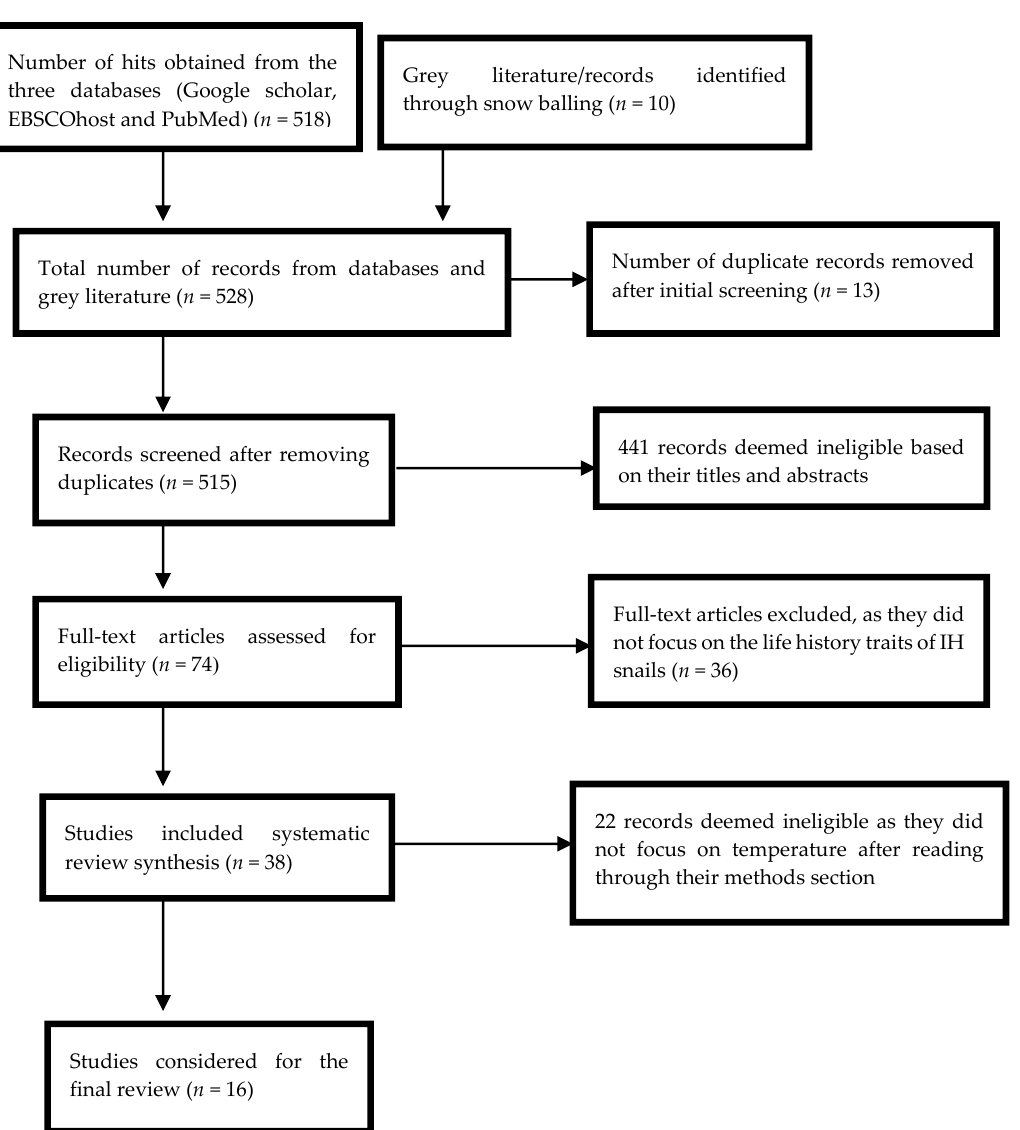
Figure 1. PRISMA diagram.